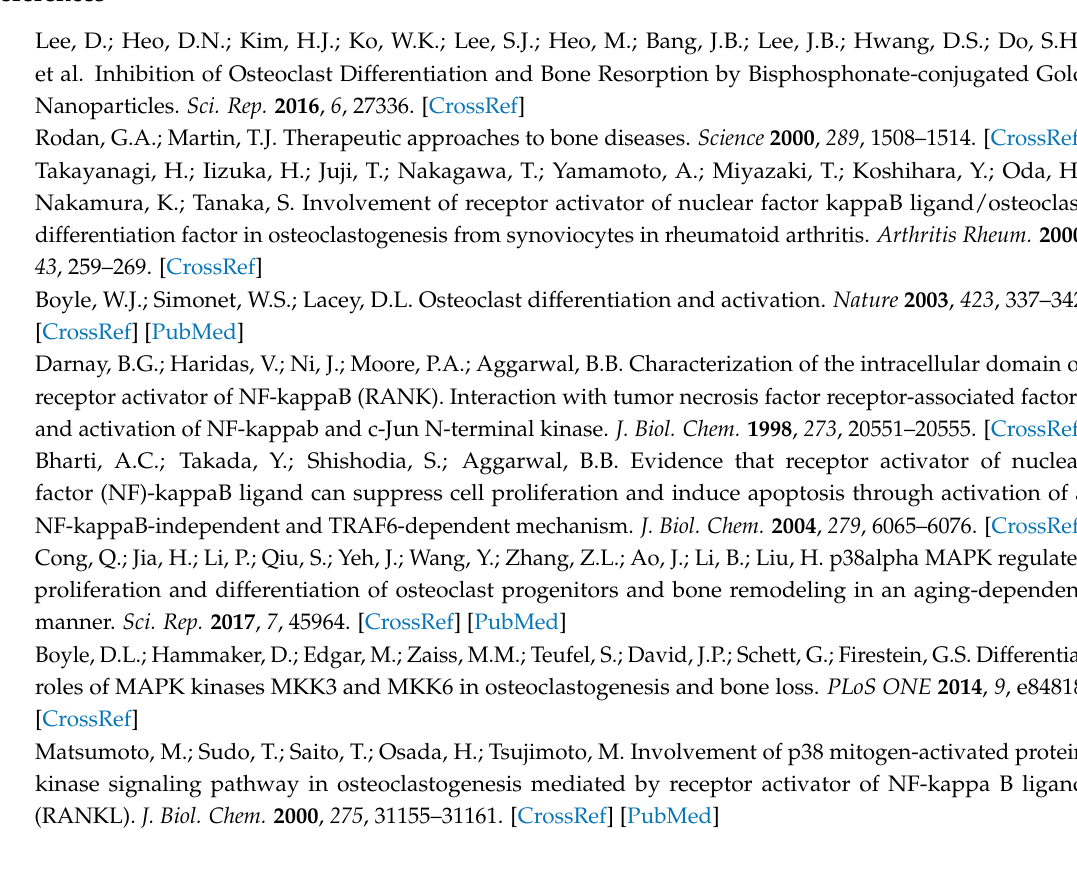
Figure S1: Viability of RAW 264.7 cells under various concentration of TAT-TN13. TAT-TN13 treated RAW 264.7 cells were tested by CCK8 assays. RAW 264.7 cells treated with the indicated concentrations of TAT-TN13 for 4 days ( n = 3). Repeated three times. The results are presented as the mean ± S.D of three independent experiments (** p < 0.01; n.s.: not significant); Figure S2. Bone resorbing activity of mature osteoclasts. RAW 264.7 cells were differentiated into osteoclasts by RANKL treatment for 4 days and we then treated TAT-TN13 (20 µ M) or SB203580 (10 µ M) for 12 h. (A) Resorption pits on the plates were captured using a light microscope (IX71; Olympus) (scale bars: 50 µ m). (B) Resorption pit areas were quantified using Olympus cellSens imaging software. The results are presented as the mean ± SD of three independent experiments (* p < 0.05, ** p < 0.01, *** p < 0.001; control